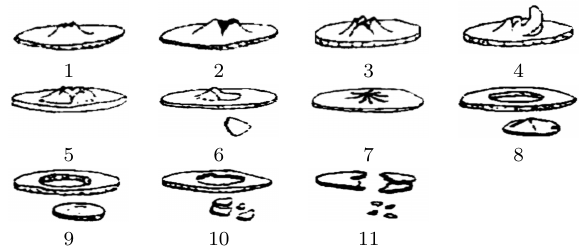
Figure 4. Fracture appearances: from ductile (1 - 5), to ductile-fragile (6 - 7), to fragile-ductile (8 - 9), up to fragile (10 - 11).